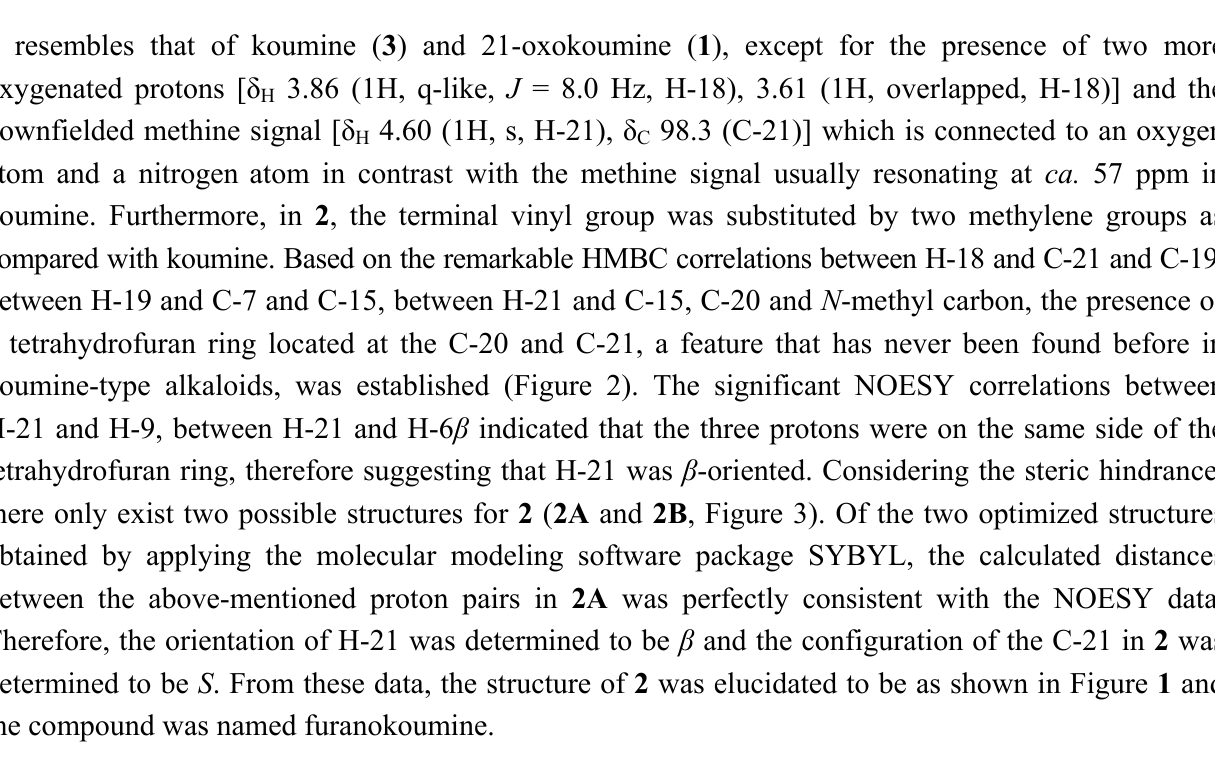
Figure 3. The two possible structures ( 2A and 2B ) for 2